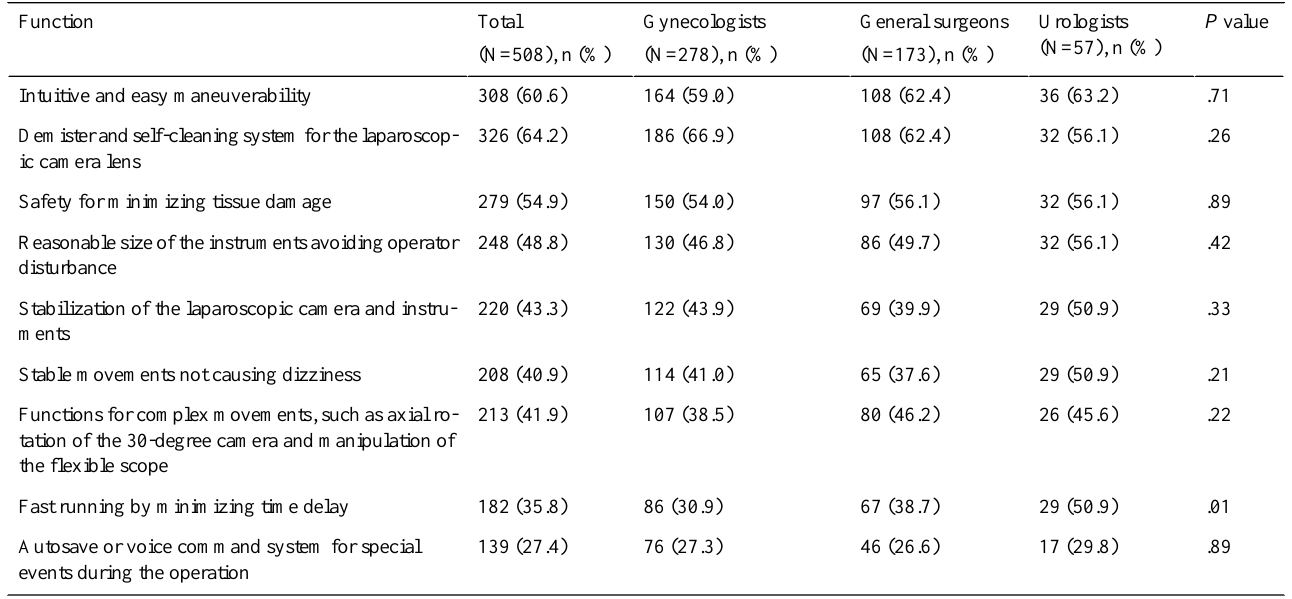
Table 4. Functions that should be included in an artificial intelligence–based surgical assistant system.